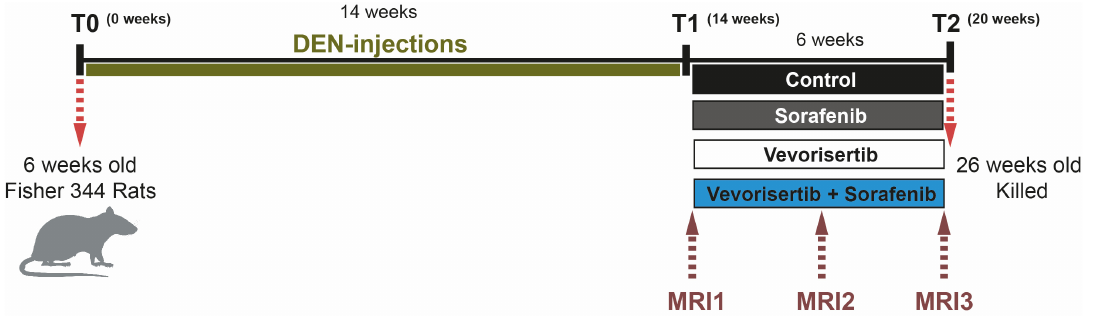
Figure 1. The schema of the study evaluating the effect of AKT inhibitor vevorisertib as a single agent and in combination with sorafenib in a DEN-induced cirrhotic rat model of HCC.